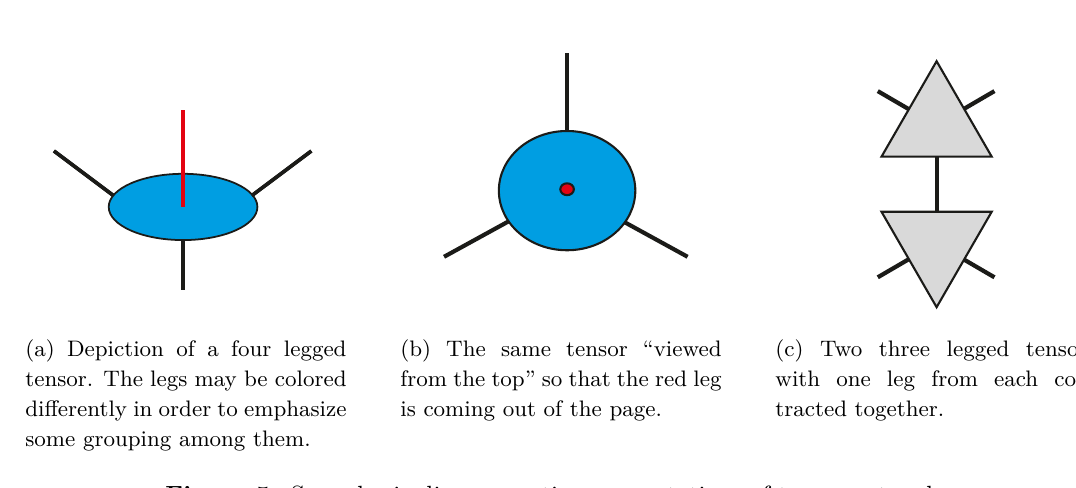
Figure 5. Some basic diagrammatic representations of tensor